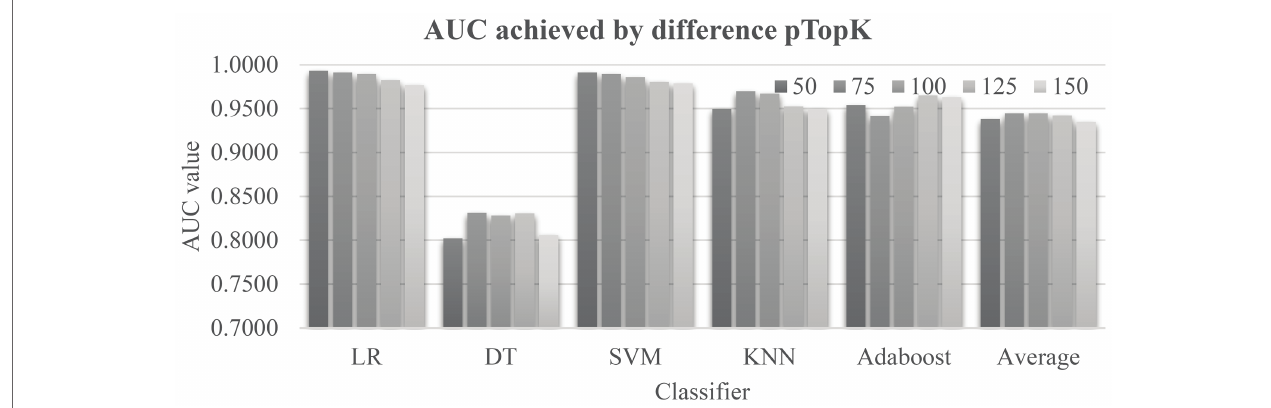
FIGURE 3 | Evaluation of the parameter pTopK of EnRank. The horizontal axis listed the five classifiers and the averaged area under the receiver operating characteristics curve (AUC) values by pTopK value. The five values, 50/75/100/125/150, are from EnRank.